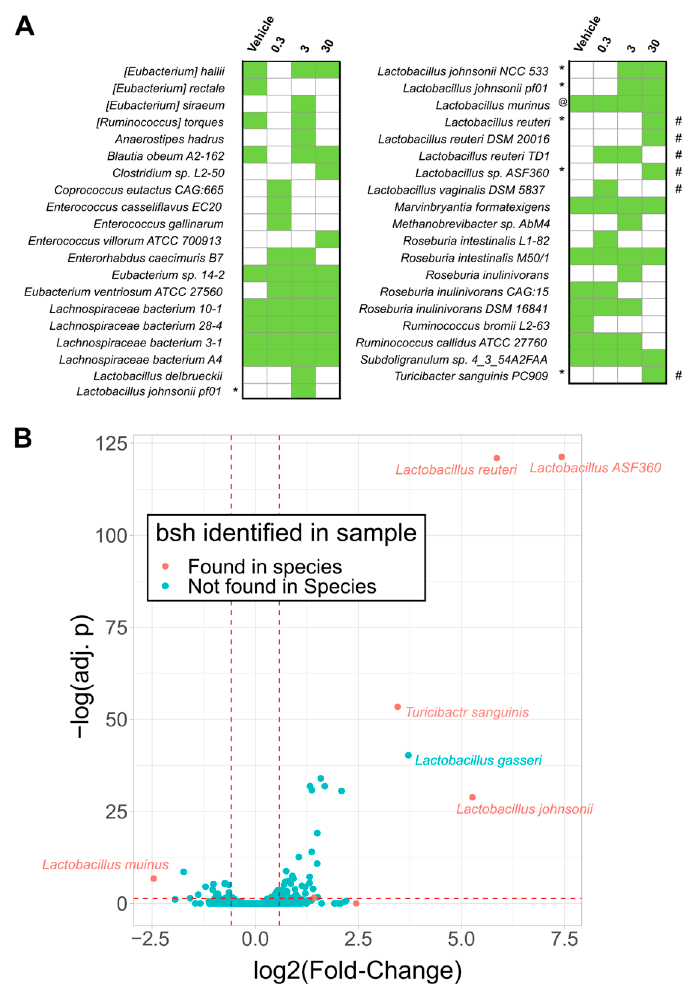
Figure 2. TCDD enriched Lactobacillus species possessing bile salt hydrolase ( bsh ). The presence of bsh gene sequences were assessed in metagenomic caecum samples from male C57BL/6 mice following oral gavage with sesame oil vehicle or 0.3, 3, or 30 µg/kg TCDD every 4 days for 28 days using three independent cohorts ( n = 3). ( A ) The presence (green boxes) or absence of bsh sequences detected in any of the metagenomic samples ( n = 3) are denoted within the respective treatment groups. Significant increases (*) or decreases (@) in normalized bsh abundances (adj. p < 0.1) are denoted. Also denoted is significantly increased species (#) determined by taxonomic analysis that